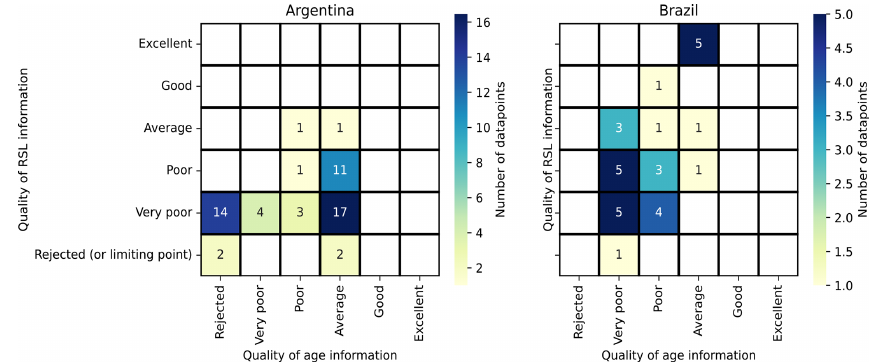
Figure 11. Heatmap summarizing the quality of age and RSL information for data in Argentina (Gowan et al., 2020) and Brazil (Rubio- Sandoval et al., 2021a). Labels inside each cell detail the number of sites with the corresponding RSL/age quality scores. The color of each cell is related to the relative frequency of each duplet of scores. The code used to create this image is available from Rovere et al. (2022).